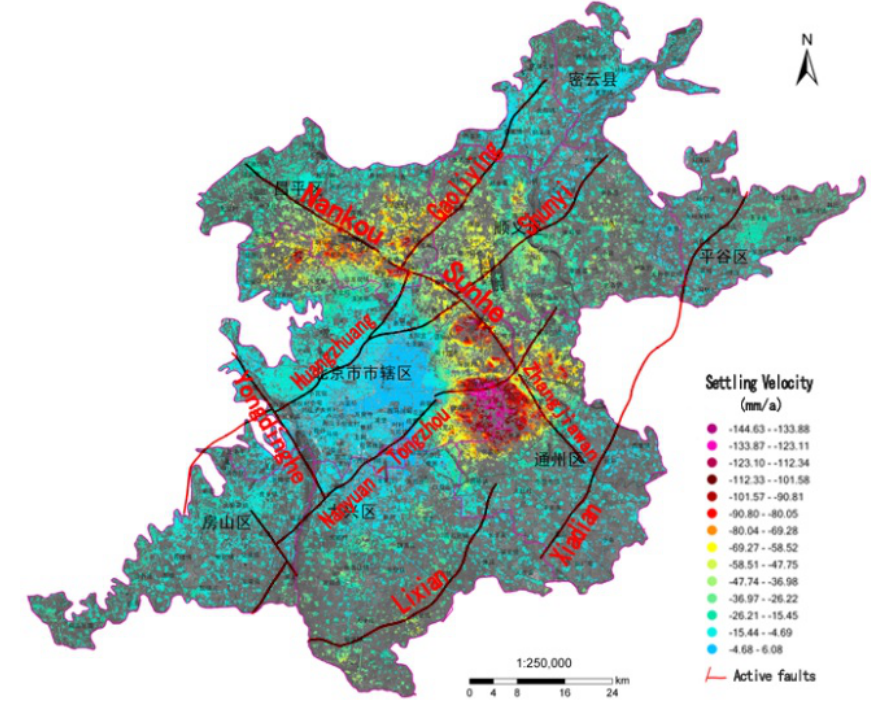
Figure 3. Distribution of subsidence rates and active faults in the